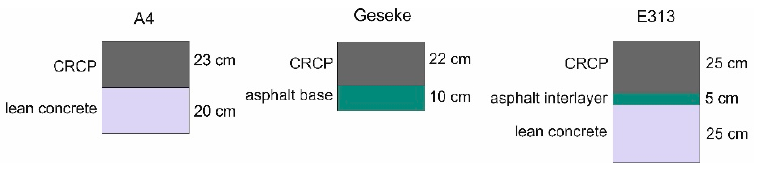
Figure 5. Design structure of test roads: Geseke ( left ), E313 ( middle ), and A4 ( right ).